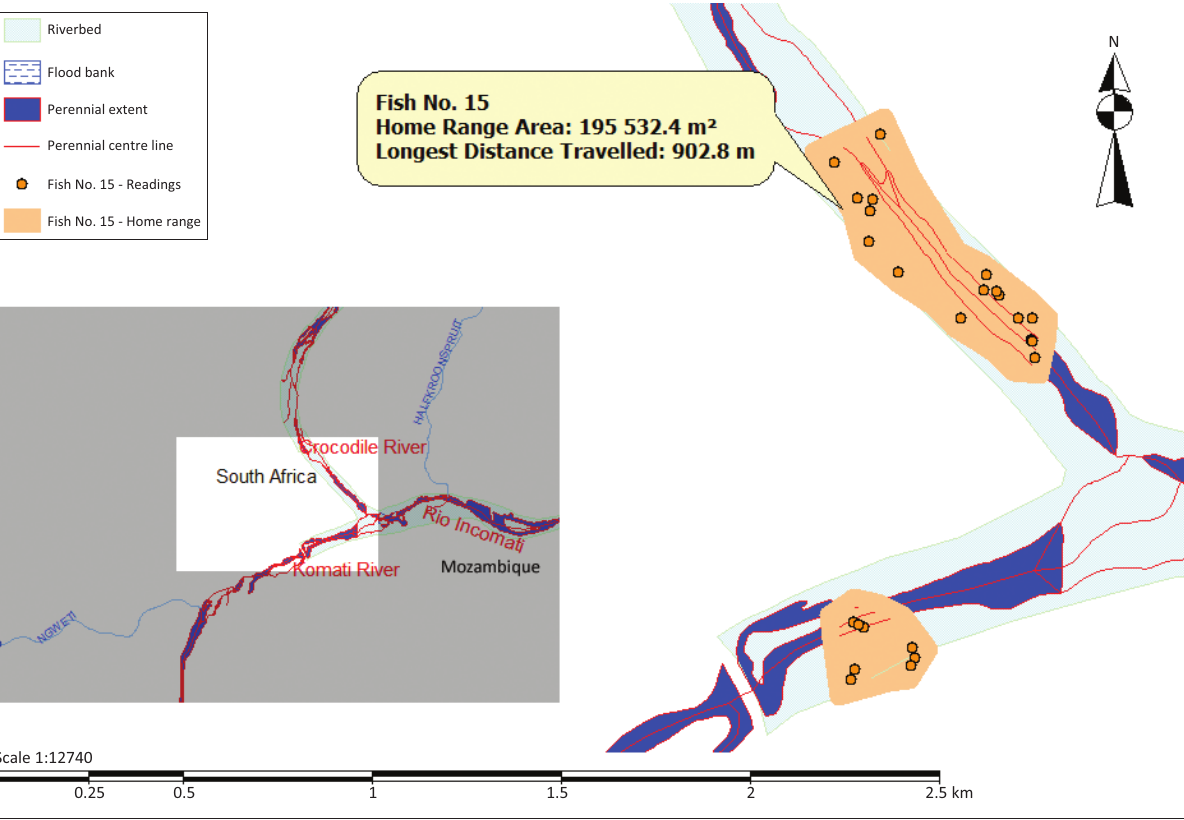
FIGURE 9: Map of radio-tagged fish number 15 indicating home range and longest distance travelled (Type 2 movement pattern).